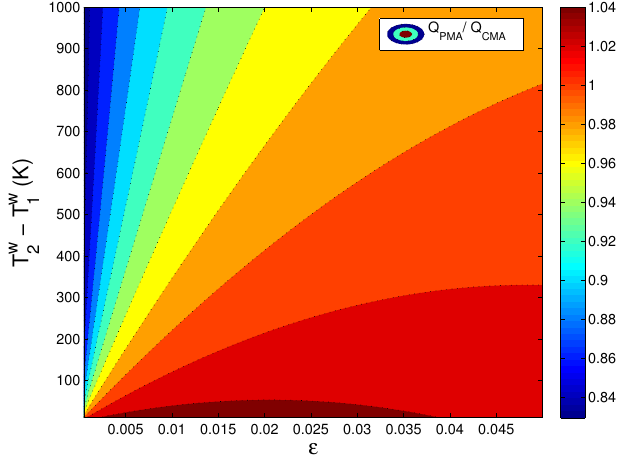
Figure 3. Comparison of heat transfer calculated in PMA and CMA under varying thermal and mechanical loading